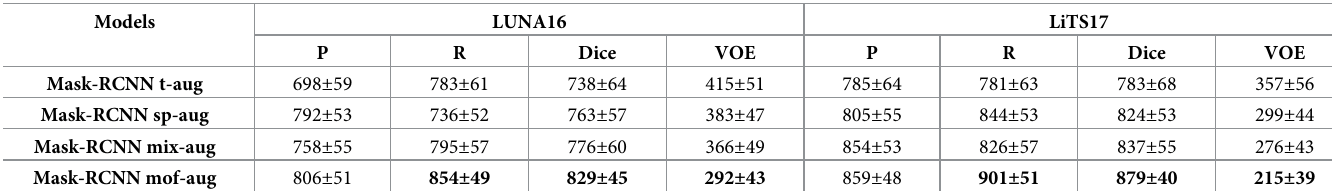
Table 5. Performance of lesion segmentation on LUNA16 and LiTS17 data sets. Models